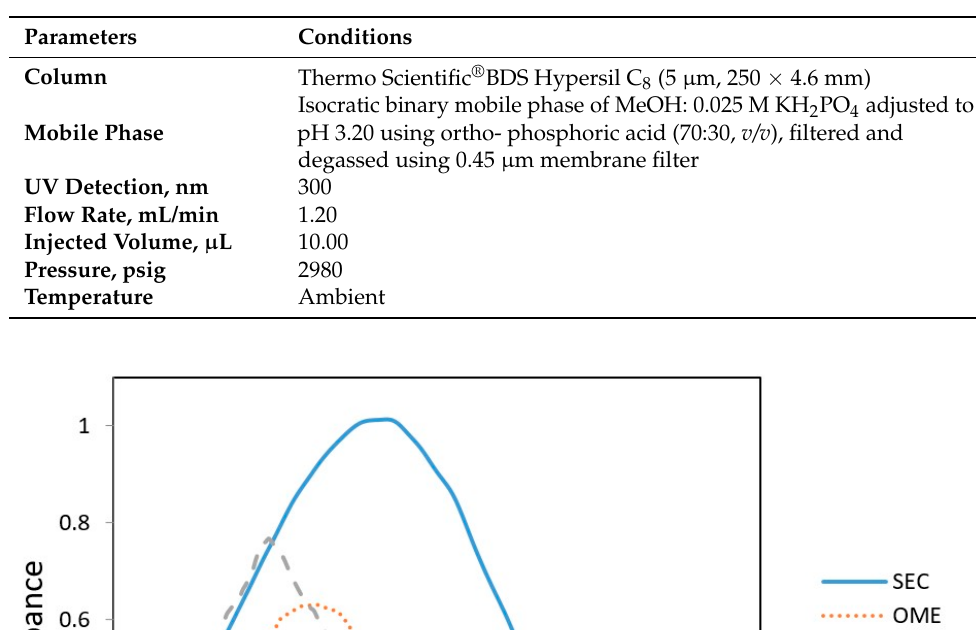
Table 1. Chromatographic Conditions for the proposed method.